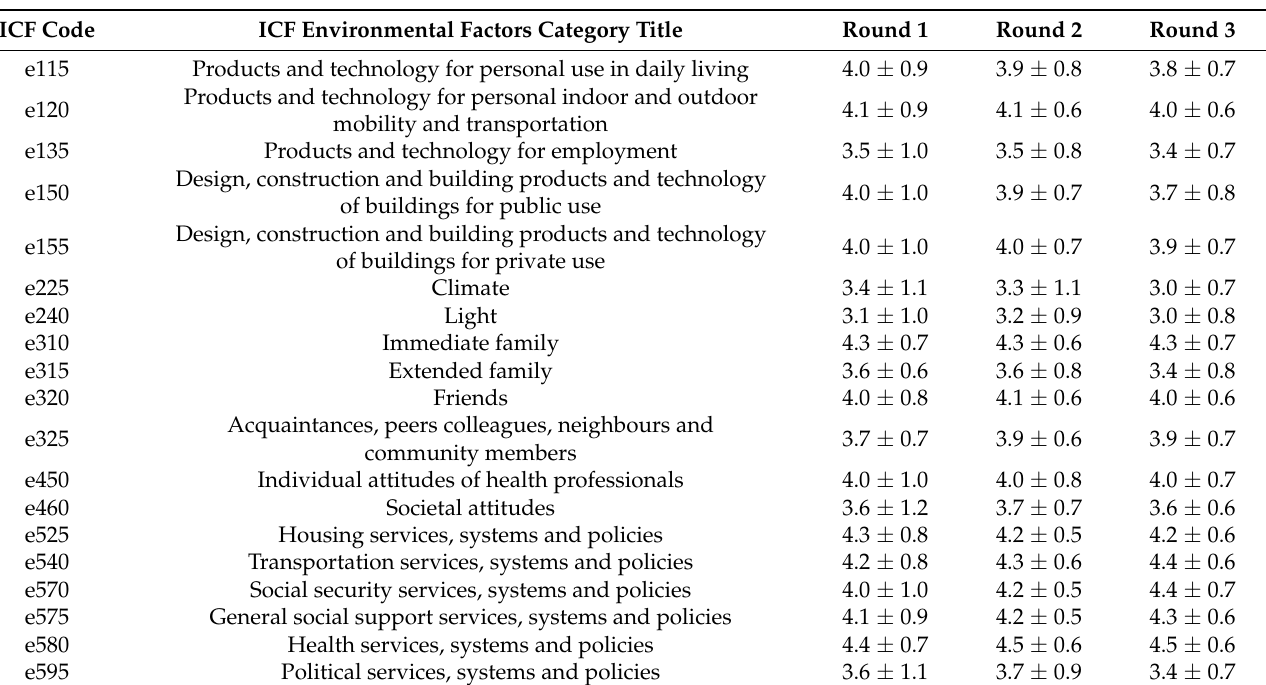
Table 4. Delphi Consensus rating scores of ICF environmental factors categories for hip fracture